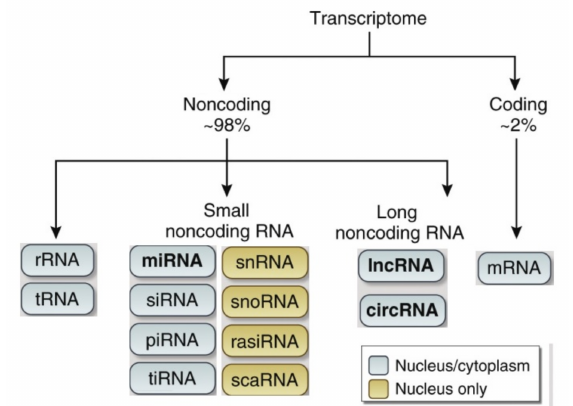
Figure 3. RNAs’ nomenclature and function. RNAs are classified based on their coding. Only two percent of RNAs code for proteins; most RNAs exert regulatory functions. lncRNA, long noncoding RNA; circular RNA; miRNA; microRNA; piRNA; piwi-interacting RNA; rasiRNA; repeat-associated small interfering RNA; scaRNA, small Cajal body-specific RNA; siRNA, small interfering RNA; snRNA, small nuclear RNA; snoRNA, small nucleolar RNA; tiRNA, transfer RNA; rRNA, stress- induced small RNA; tRNA, transfer